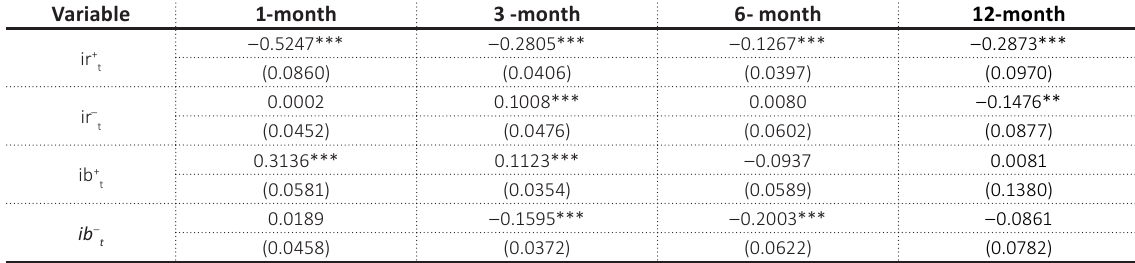
Table 6. Long-run coefficient